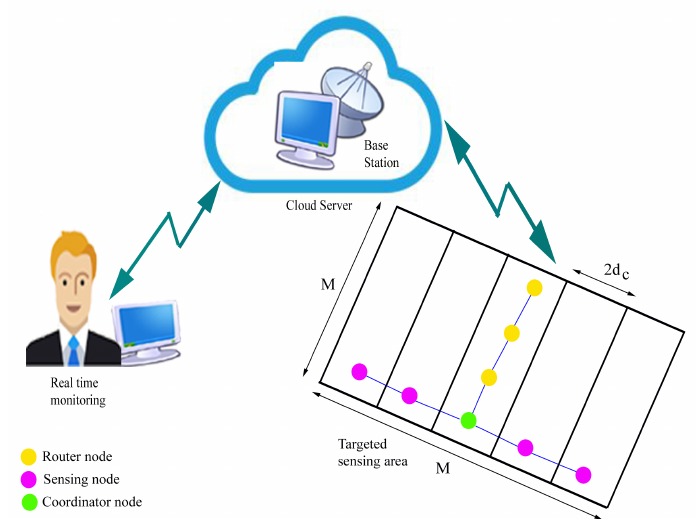
Figure 1. General diagram of proposed